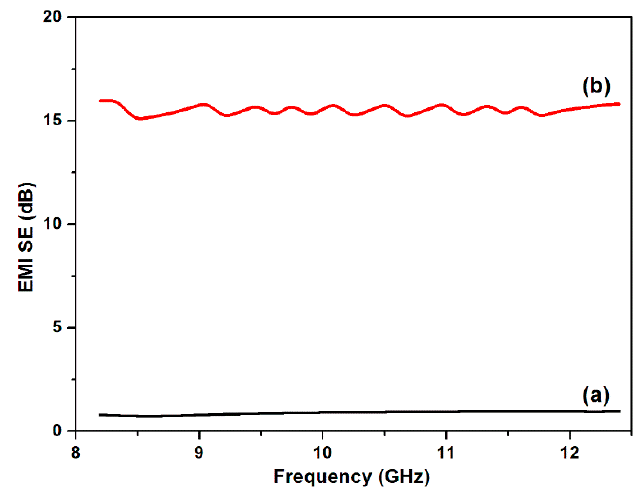
Figure 12. Electromagnetic interference shielding effectiveness (EMI SE) properties of ( a ) PET fabrics and ( b ) Cu/Ag/PDA/PET fabrics.